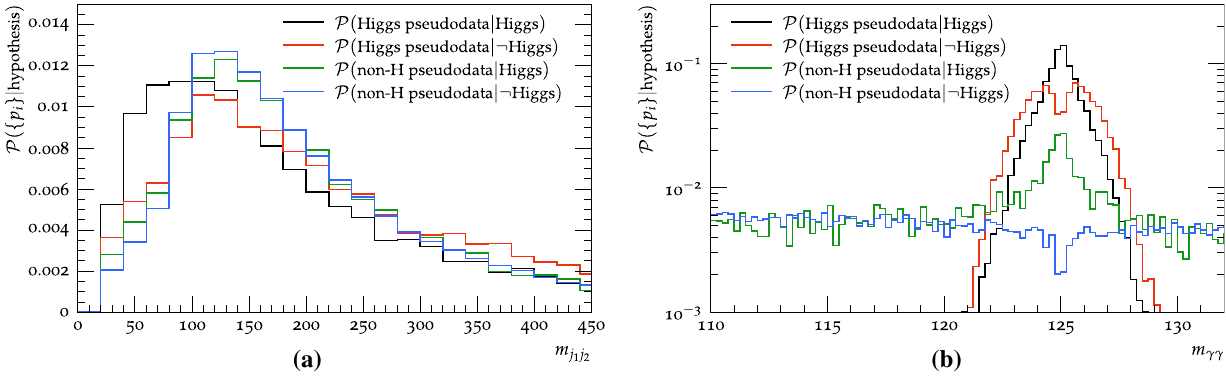
Fig. 5 Probabilities to identify signal or background pseudodata according to “Higgs-signal” and “non-Higgs signal” hypothesis, as function of the dijet invariant mass and the diphoton invariant